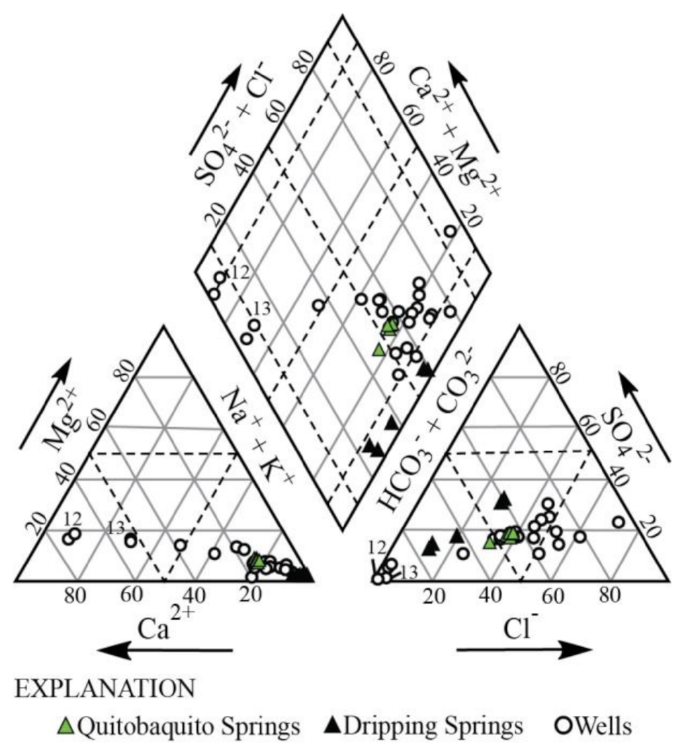
Figure 9. Piper Diagram showing major ion chemistry data for springs and well water samples in the study area.